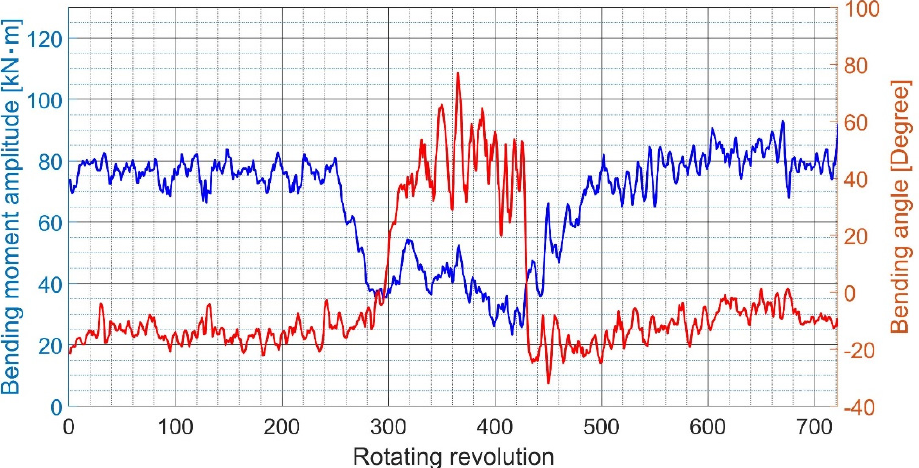
Figure 10. Bending moment during the port turn under the fully laden condition.